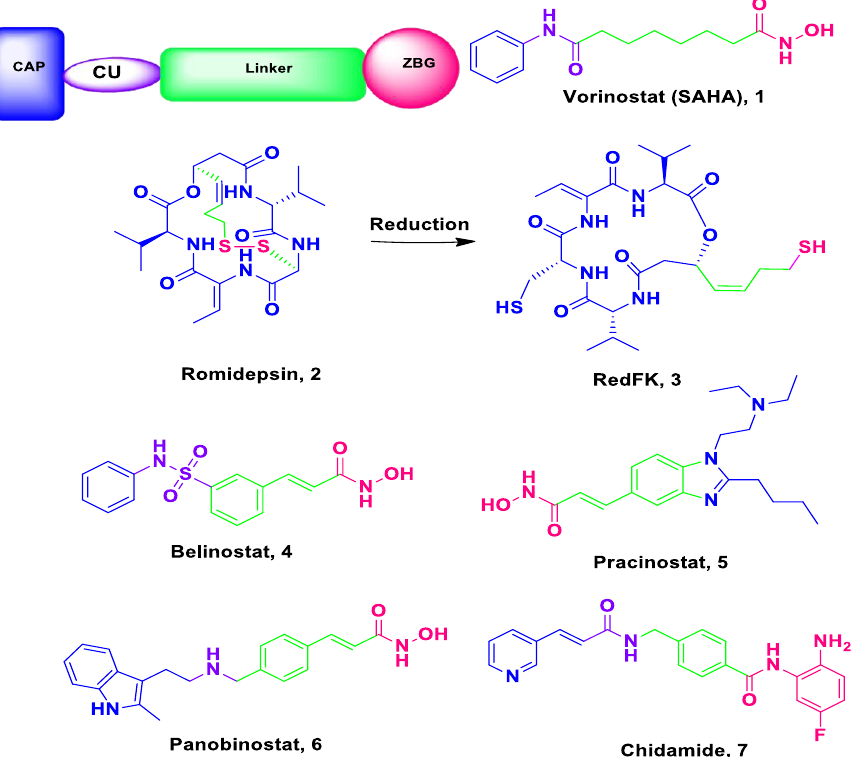
Figure 1. Pharmacophoric elements and structures of the official HDAC inhibitors.